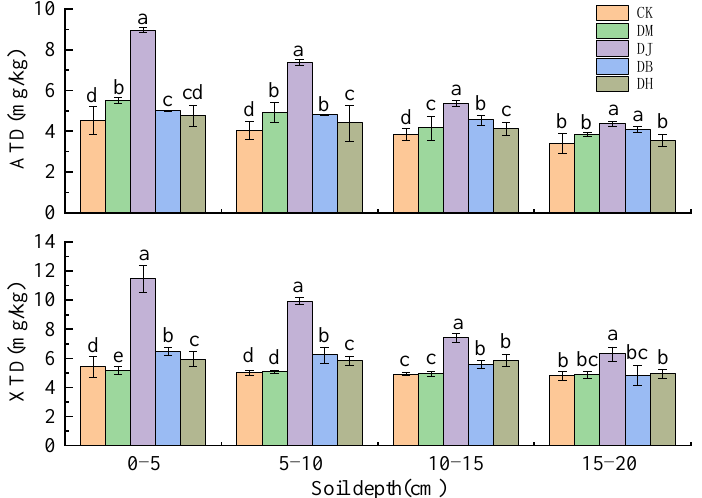
Figure 5. Distribution changes of soil nitrogen in different treatments. XTD: soil nitrate nitrogen, ATD: soil ammonium nitrogen.